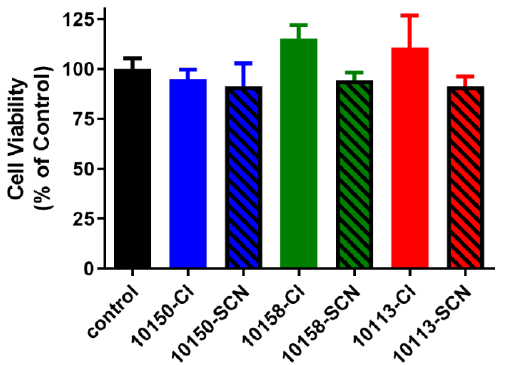
Figure 8. Manganese porphyrin formulations are well tolerated by human airway epithelial cells . Human bronchial epithelial cells (16HBE41o-) were treated with 100 µ M of manganese meso -porphyrins (MnPs) in their chloride (Cl, solid bars) or thiocyanate (SCN, hatched bars) formulations for 24 h, and cell viability was assessed using the MTT assay. No significant differences were observed between the treatment groups and the control.